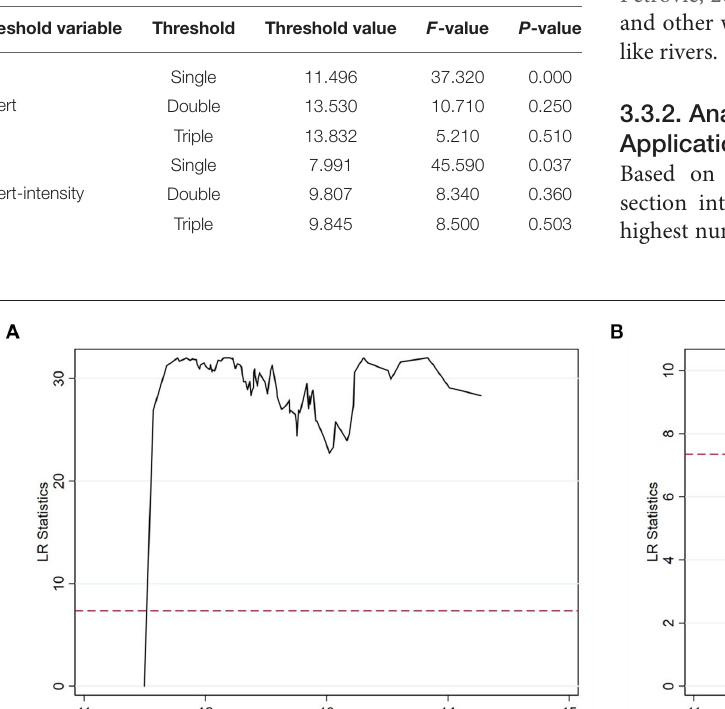
TABLE 4 | Test of the threshold effect.